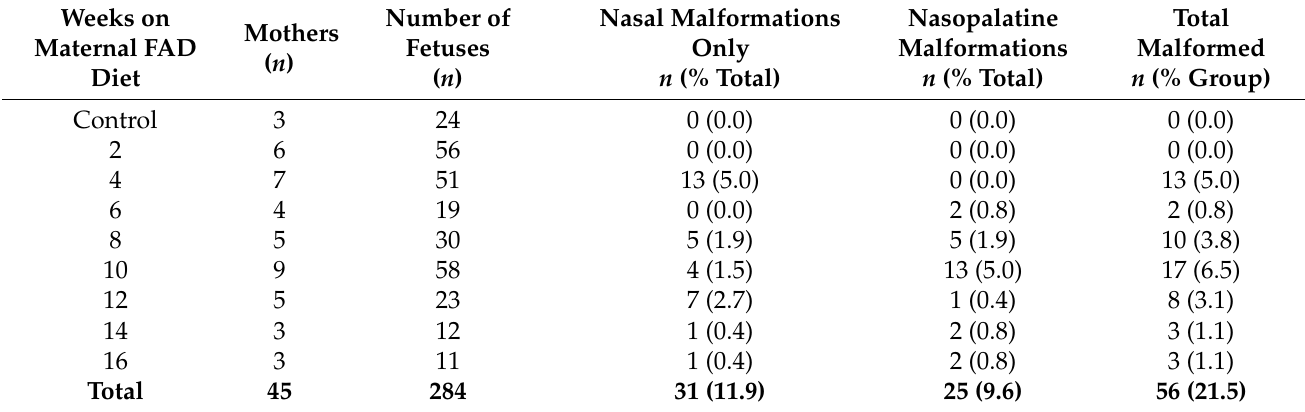
Table 1. General outcome. Number of fetuses and incidence of malformation per week on a maternal folic acid-deficient (FAD) diet. Weeks on Maternal FAD